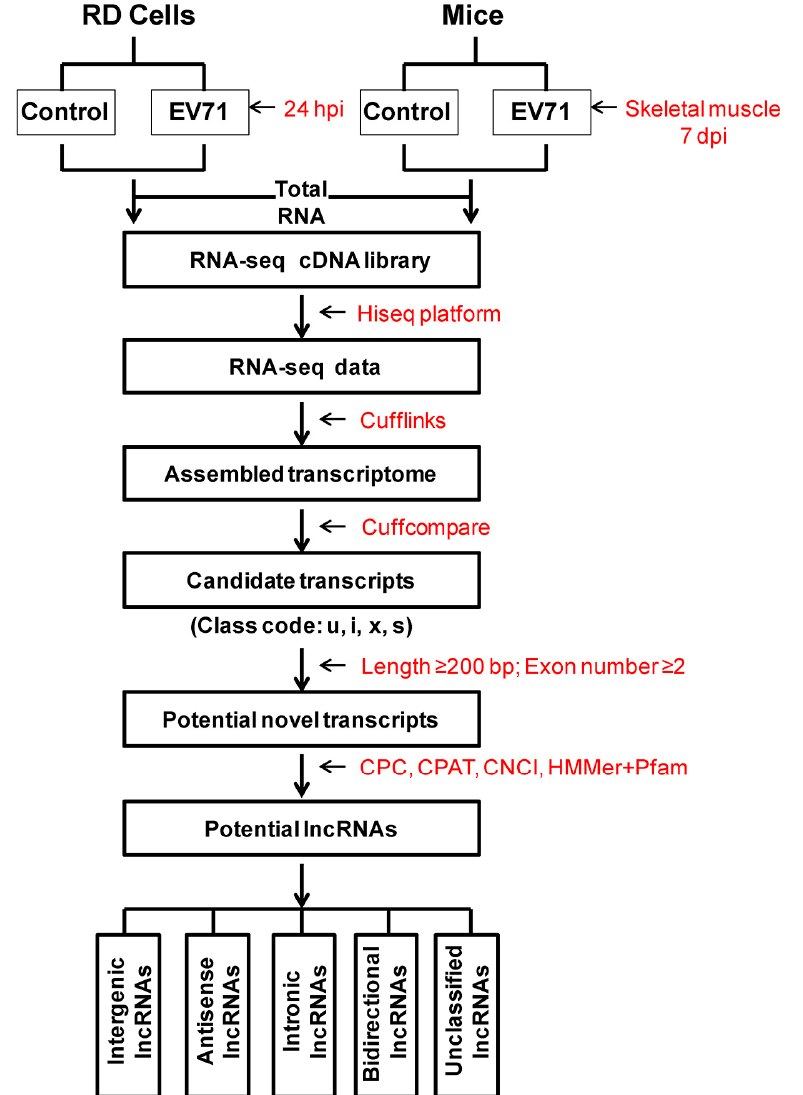
Figure 1. Flow chart for novel lncRNA identification and classification. RD = rhabdomyosarcoma. EV71 = Enterovirus 71. hpi = hours post-infection. dpi = days post-infection. lncRNAs = long non-coding RNAs. The CPC, CPAT, CNCI and HMMer+ Pfam are software for predicting the coding ability of transcripts.